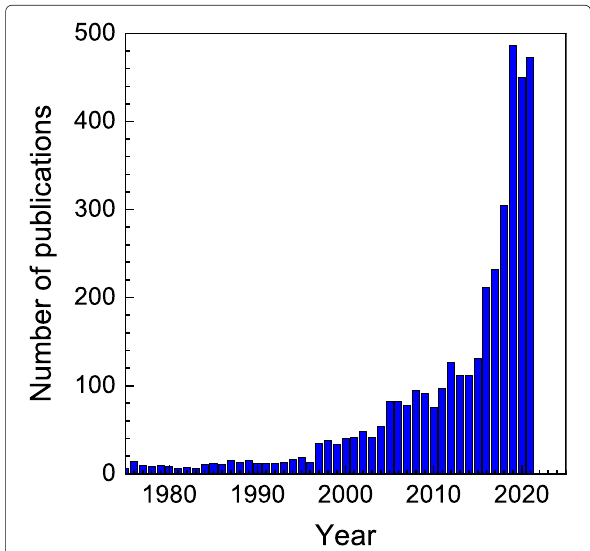
Fig. 1 Number of publications on Ga 2 O 3 from 1975 to 2020. The papers were searched with criterion of containing “Ga 2 O 3 ” in the title (data: Web of Science as of November 30,